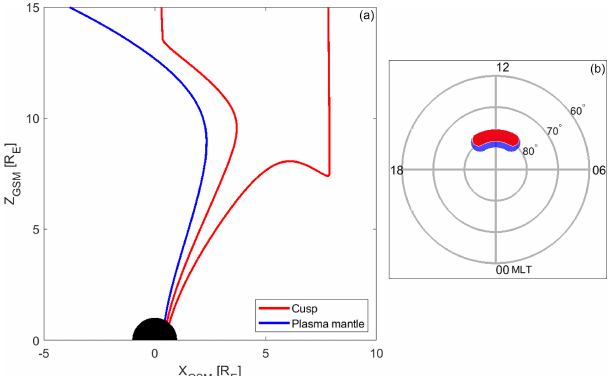
Figure 1. Schematic representation of the cusp and plasma mantle regions determined from the T96 model. Panel (a) depicts boundary field lines in the XZ GSM plane. Panel (b) depicts schematic (sym- metric) areas of the cusp and plasma mantle in the polar cap. The cusp is represented with red and the plasma mantle with blue.